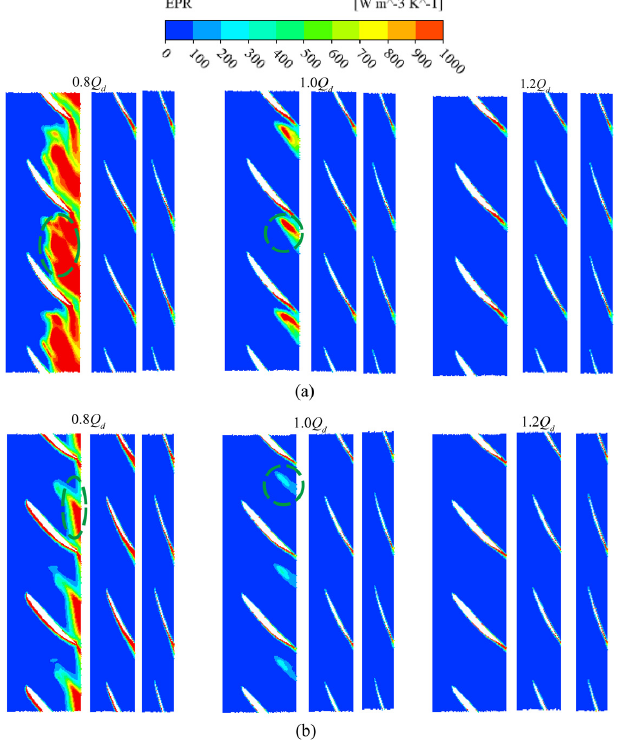
Figure 16. The distribution of EPR in the impeller:( a ) Original impeller, and ( b ) Optimized impeller. (From left to right of each item is r * = 0.02, 0.5, and